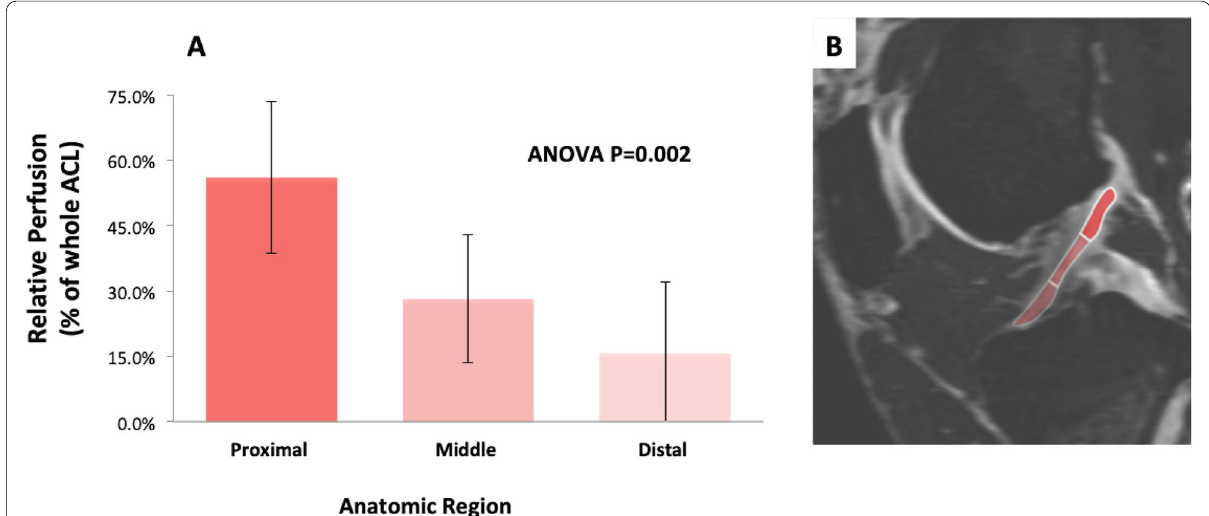
Fig. 3 The greatest mean relative perfusion (as a percentage of the total ACL perfusion) was seen in the proximal ACL region (56% followed by the middle region (28.2%